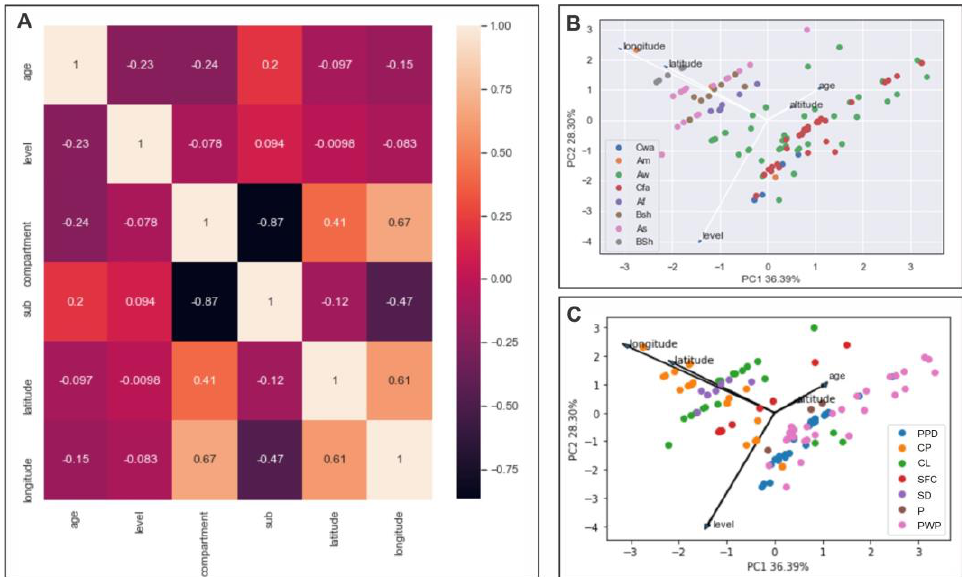
Figure 6. ( A ) Correlation matrix: the image shows the correlations between variables. Correlations are calculated using normalized values. ( B ) Principal Component Analysis (PCA) between continental compartments based on the Köppen climate classification, and ( C ) between geomorphological subcompartments, respectively.